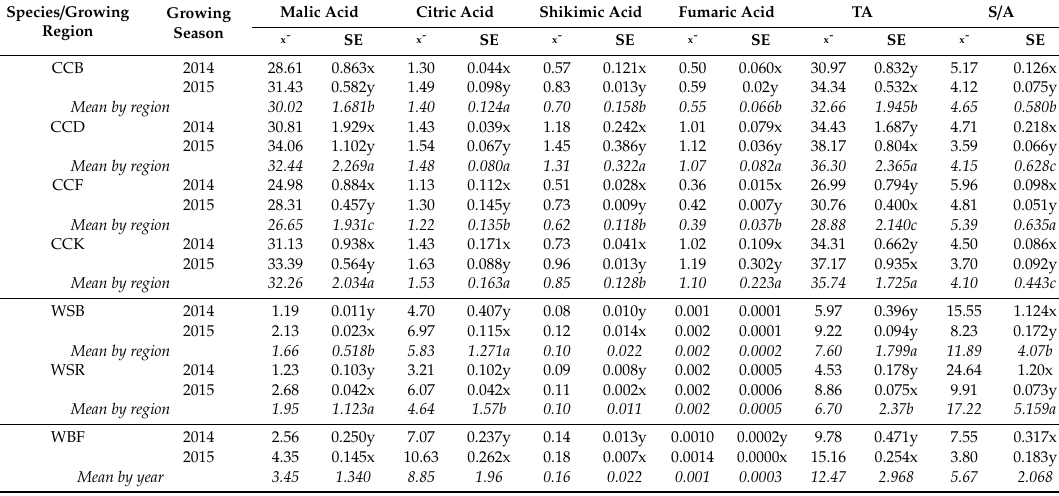
Table 4. Cont. Table 3. Average content of individual sugars, total sugars (TS) and glucose/fructose ratio (G/F) ± SE Table 3. Average content of individual sugars, total sugars (TS) and glucose/fructose ratio (G/F) ± SE Table 3. Average content of individual sugars, total sugars (TS) and glucose/fructose ratio (G/F) ± SE Table 3. Average content of individual sugars, total sugars (TS) and glucose/fructose ratio (G/F) ± SE Table 3. Average content of individual sugars, total sugars (TS) and glucose/fructose ratio (G/F) ± SE Table 3. Average content of individual sugars, total sugars (TS) and glucose/fructose ratio (G/F) ± SE in analyzed wild fruit species (g kg − 1 FM (fresh mass))*. in analyzed wild fruit species (g kg − 1 FM (fresh mass))*. in analyzed wild fruit species (g kg − 1 FM (fresh mass))*. in analyzed wild fruit species (g kg − 1 FM (fresh mass))*. in analyzed wild fruit species (g kg − 1 FM (fresh mass))*. in analyzed wild fruit species (g kg − 1 FM (fresh